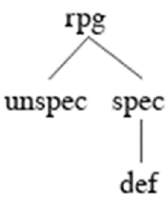
Figure 3. Geometry of the organizing node (ON) rpg.